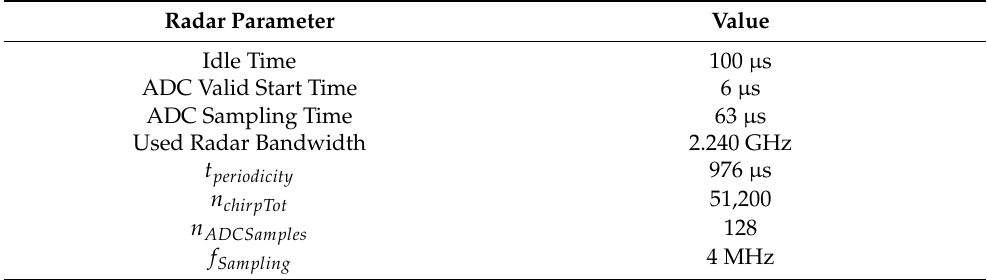
Figure 8. Top-view representation of the experimental setup. The drone and the radar are positioned on two different tripods at a distance d = 1.673 m. Table 1. Radar